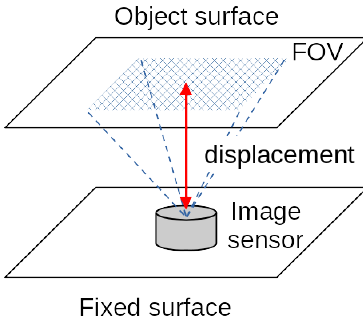
Figure 3. Conceptual diagram of an image-based displacement sensor. For example, it is installed in the gap between two structures and monitor changes in the distance between them. An image sensor is fixed on one side (fixed plane), and an image of the other side (object plane) is acquired to measure the